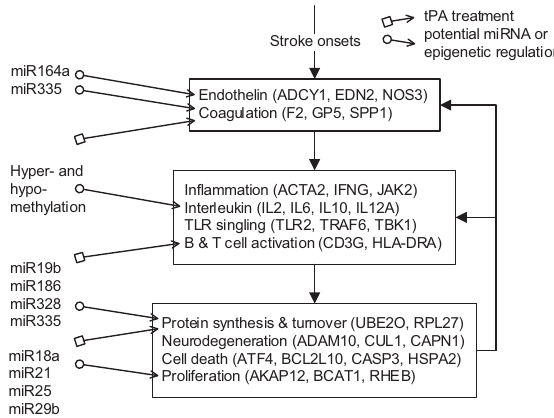
Figure 5. Diagram of the pathomechanism of early CE stroke and the enriched functions regulated by tPA treatment and miRNAs, showing functions and proteins a ff ected after CE stroke onset. Symbol arrows indicate where tPA treatment ( (cid:128) ) and miRNA regulation ( (cid:145) ) can interfere with the progression of stroke and potential targeted functions and proteins.